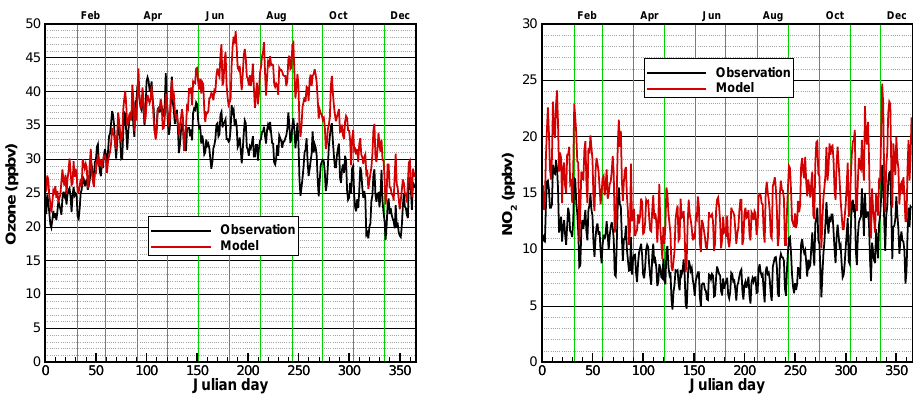
Fig. 4. Daily domain-wide average ozone and NO 2 concentrations in